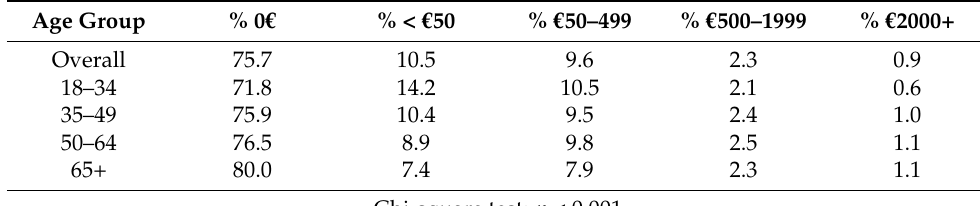
Table 4. Percentage of financial losses in weighted